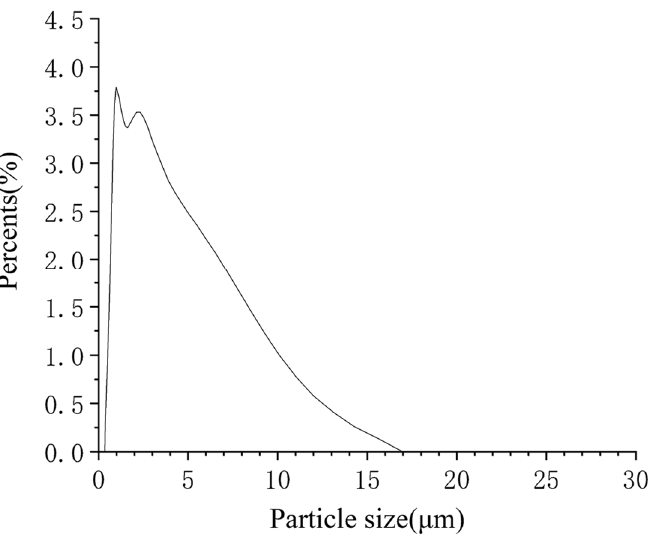
Figure 2. Laser particle size distribution of the purified product. The horizontal coordinate indicates the particle size and the vertical coordinate indicates the percentage of particles in the total sample at the corresponding size.